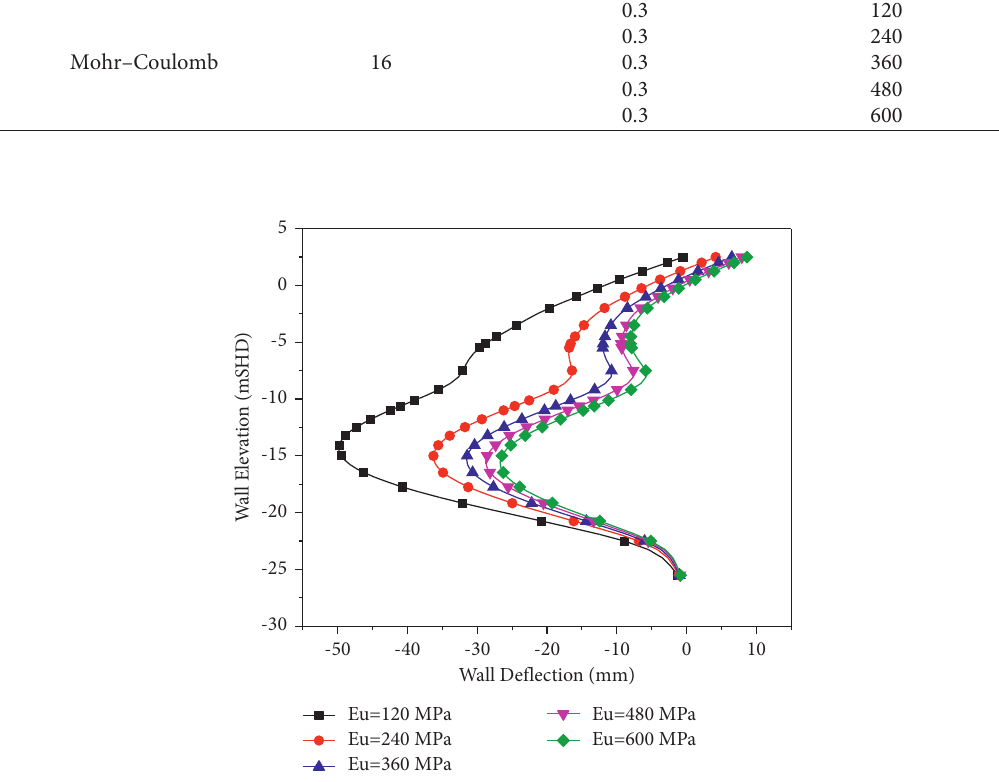
Figure 13: The effect of ground improvement Eu on wall deflection.